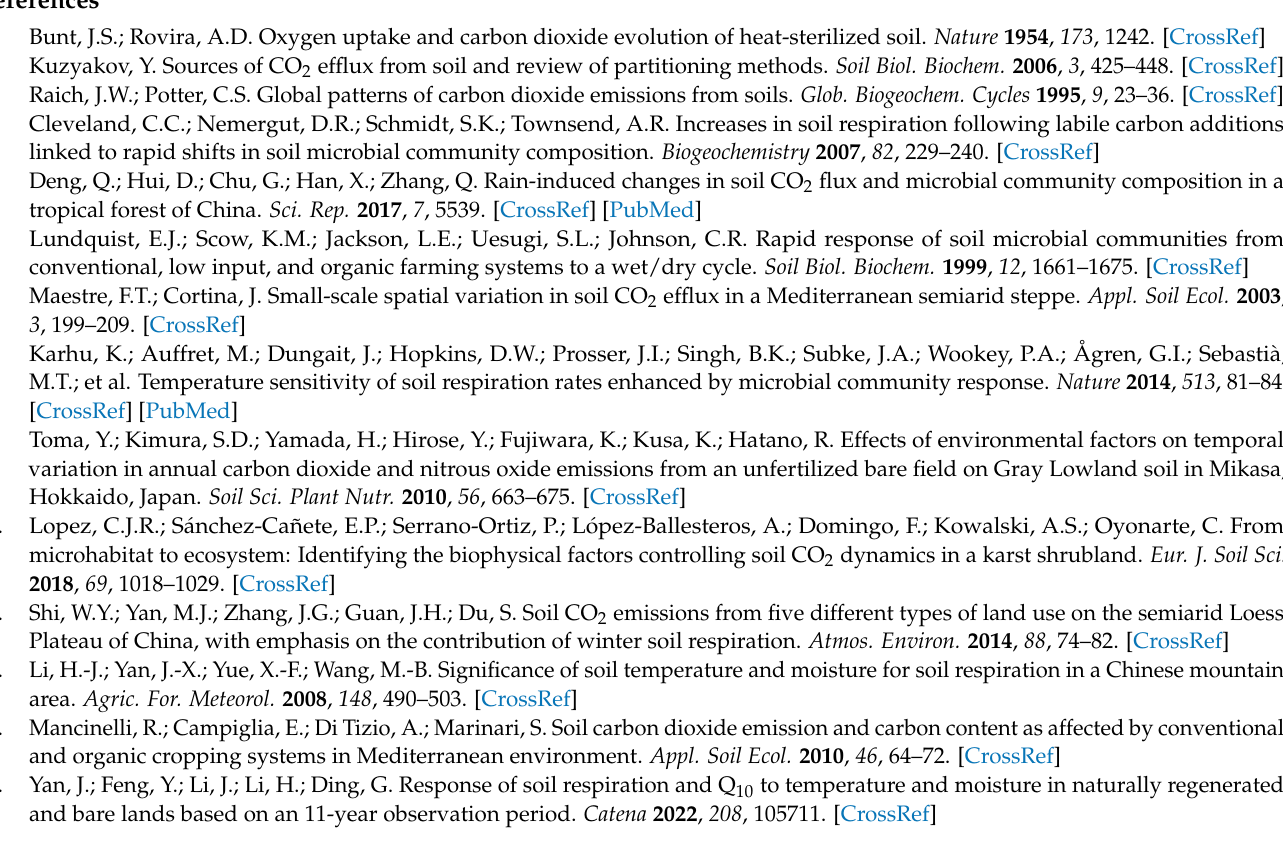
estimated results; Figure S3. Exponential model fitted to the CO 2 efflux (g m − 2 h − 1 ) from undisturbed bare soil as a function of the soil temperature. Measured and calculated data are represented by black and red circles, respectively; Figure S4. Hourly CO 2 efflux (g m − 2 h − 1 ) of undisturbed bare soil, calculated with the exponential model with the consideration of soil temperature, for the years of 2018—2021; Table S1. Mean and standard deviation of measured soil temperature, soil moisture content, and CO 2 efflux data by years used as inputs for model